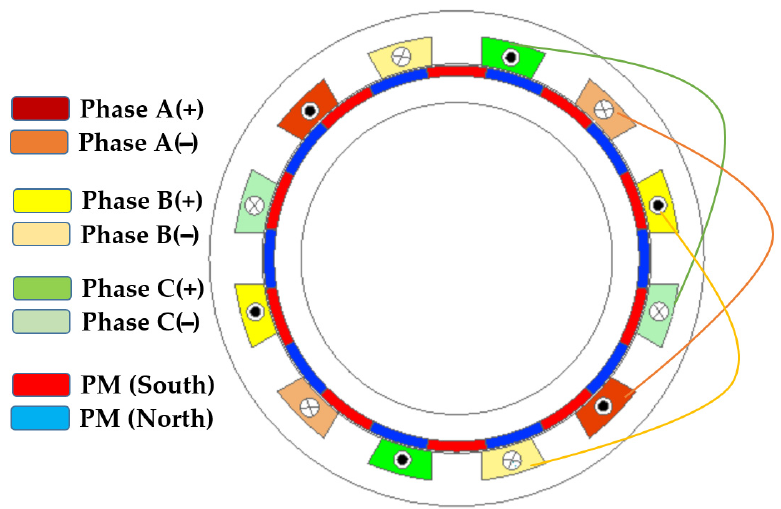
Figure 3. Cross-section of the designed prototype.